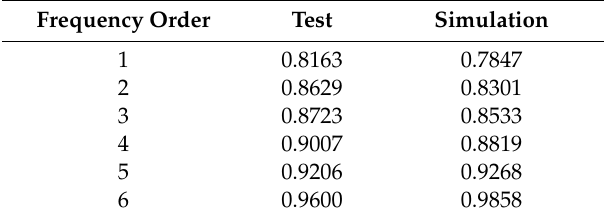
Figure 6. Test model by full-model vibration exciter method. Table 4. Natural frequencies (Hz) of test and simulation for Model 1.